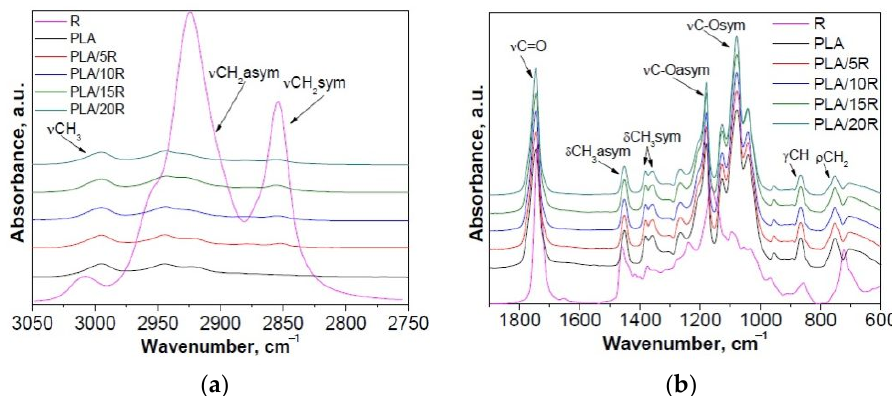
Figure 1. Normalized ATR-FTIR spectra of PLA/R samples compared with neat PLA and R: ( a ) 2750–3050 cm − 1 and ( b ) 600–1900 cm − 1 spectral range.